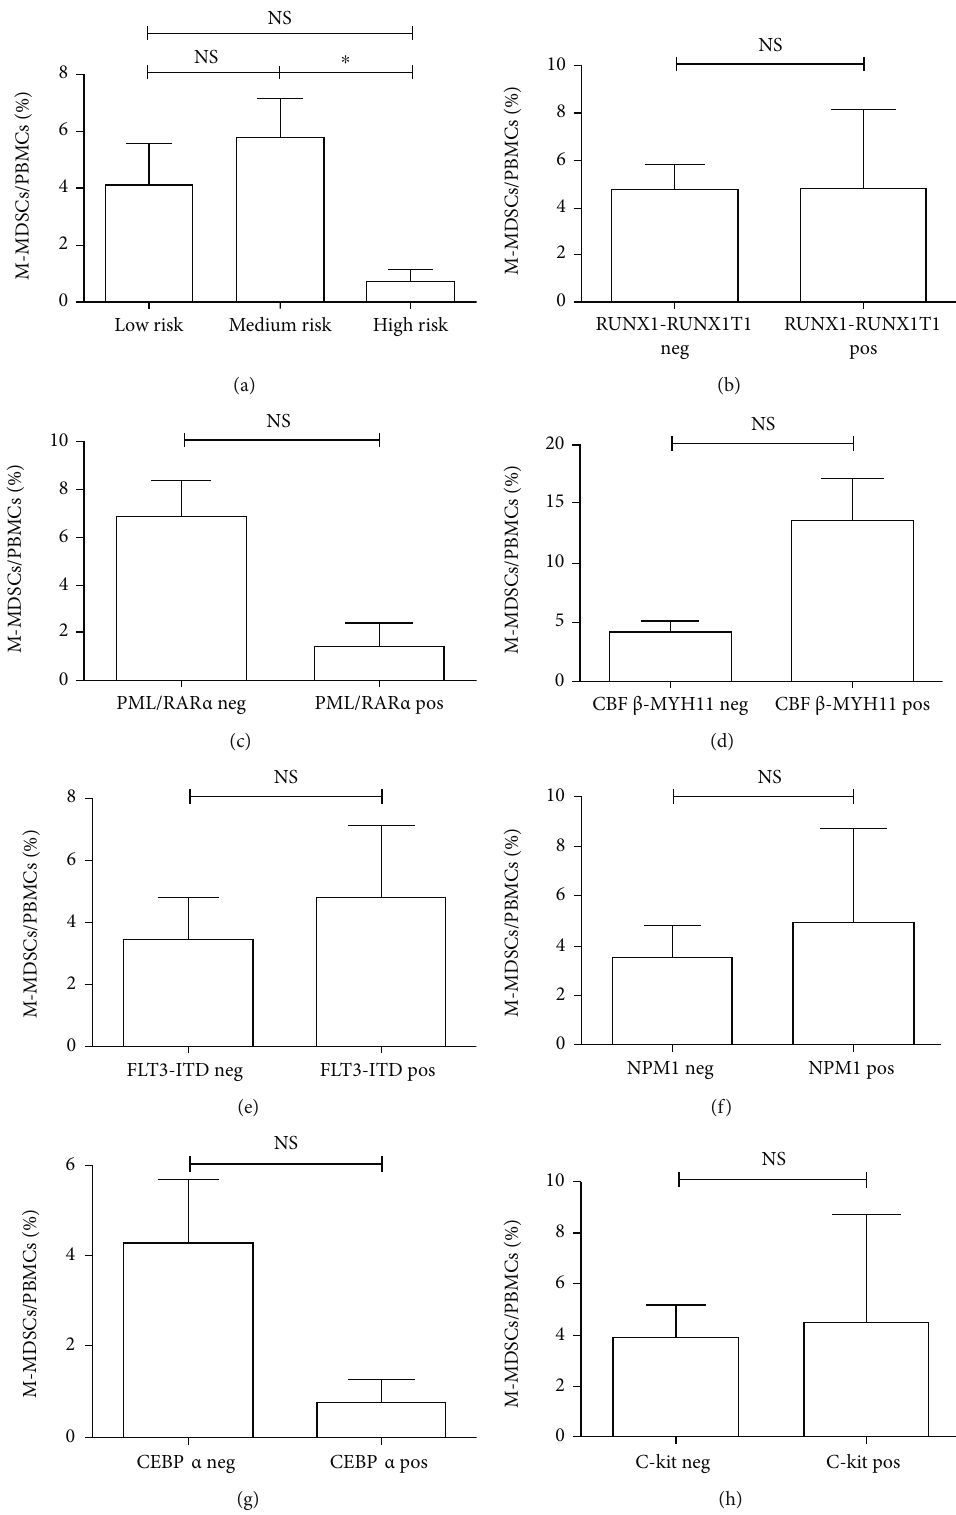
Figure 4: The correlation of circulating M-MDSC frequency and cytogenetic/molecular risk categories in AML. No signi fi cant statistical di ff erences in circulating M-MDSCs were found in the di ff erent groups of karyotype strati fi cation, fusion gene, and gene mutation (a – h). NS: not signi fi